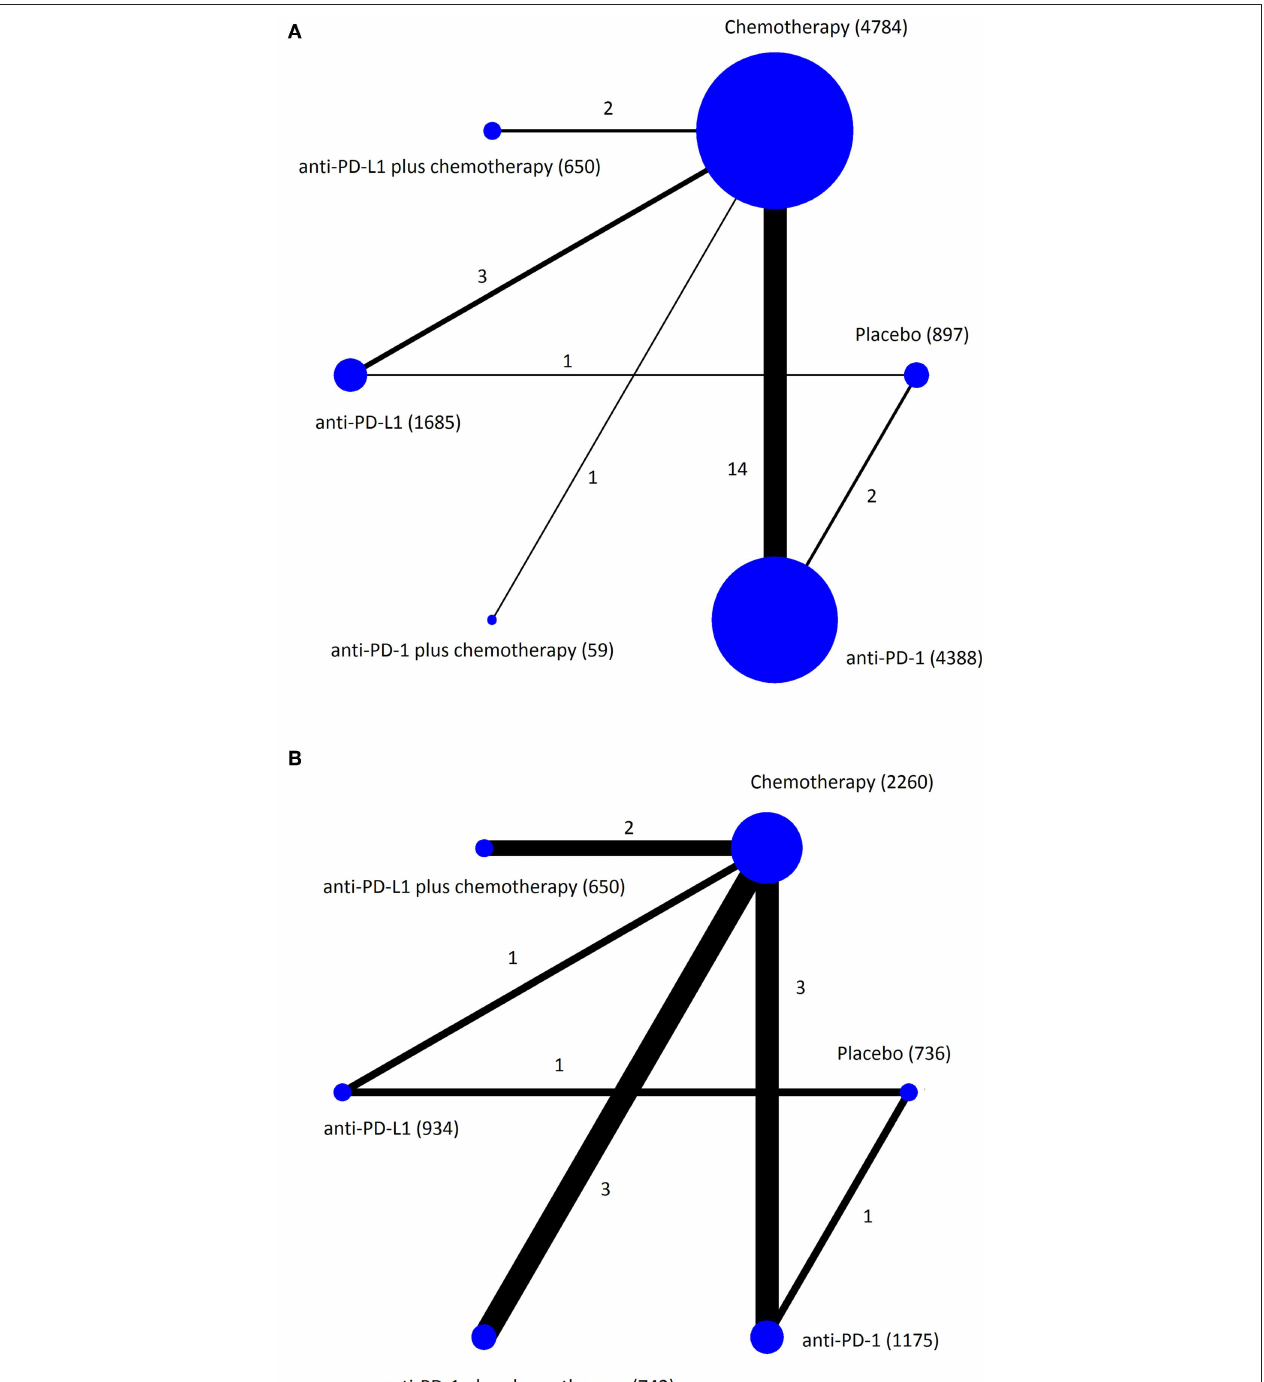
FIGURE 2 | Network plots of eligible comparisons for the Bayesian network meta-analysis. The size of the nodes is proportional to the number of patients (in parentheses) randomized to receive the treatment. The width of the lines is proportional to the number of comparisons (beside the line) comparing the connected treatment (nodes). A total of 23 comparisons were analyzed for treatment-related adverse events (A) ; a total of 11 comparisons were analyzed for immune-related adverse events (B) .